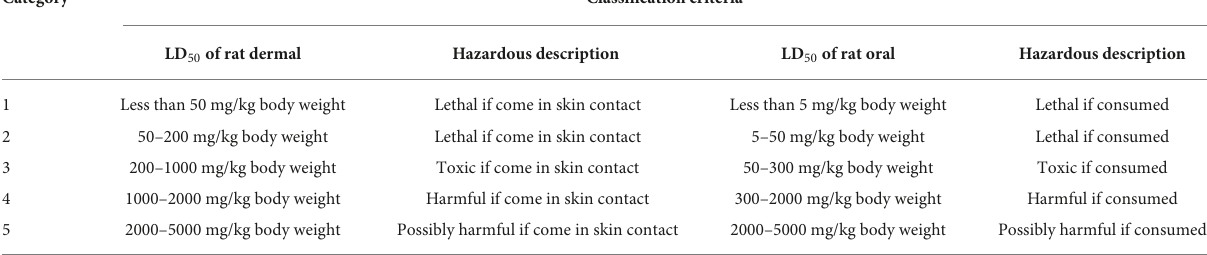
TABLE 3 Pesticides classification according to the Globally Harmonized System GHS (World Health Organization,